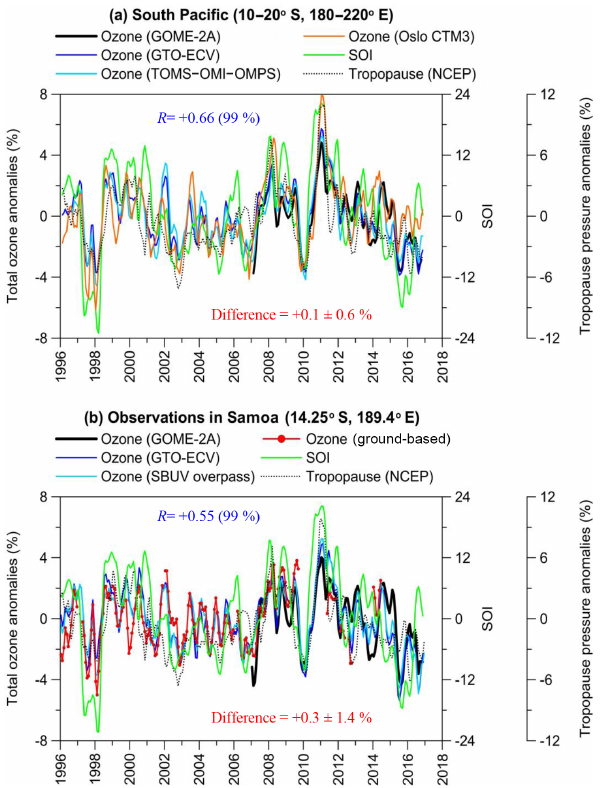
Figure 9. (a) Example of regional time series of total ozone (%) over southern Asia (35–45 ◦ N, 45–125 ◦ E) along with SOI. The dot- ted line shows the respective tropopause pressure variability from NCEP. R is the correlation coefficient between GTO-ECV total ozone and SOI (statistical significance of R is given in parenthe- ses). The difference refers to the mean difference ± σ (in %) be- tween GTO-ECV and the combined TOMS–OMI–OMPS satellite data; (b) same as in (a) but with SBUV overpass and GB data aver- aged at seven stations in southern Asia. The difference refers to the mean difference ± σ (in %) between GTO-ECV and GB